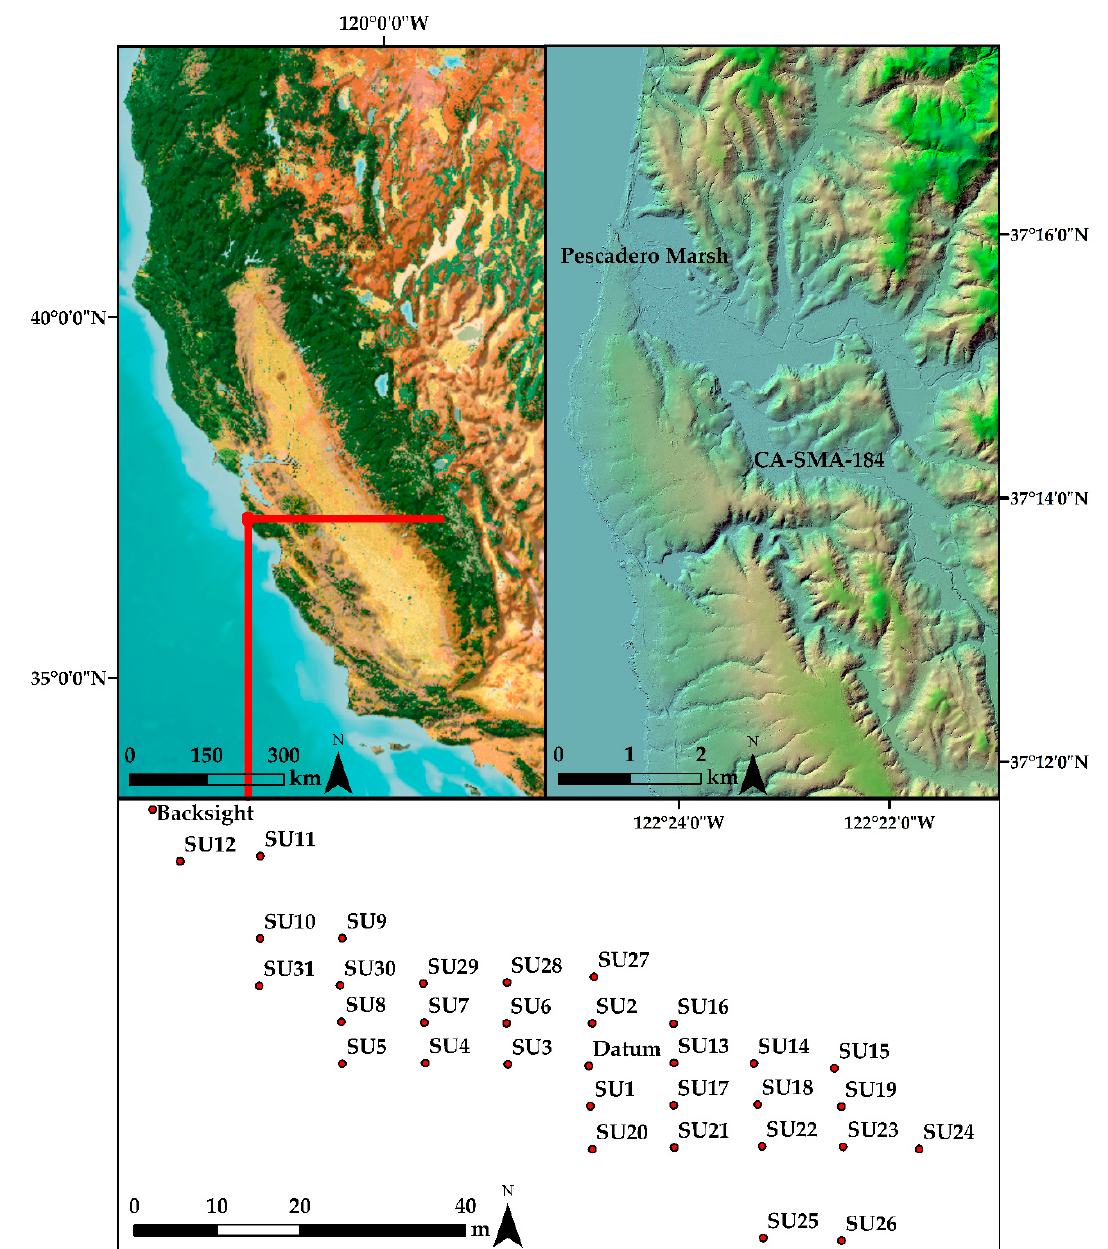
Figure 1. Left : Overview of the California coast with the general location of the study area. Right : Inset map of the project area, including Pescadero Marsh and the location of the CA-SMA-184, otherwise known as the Butano Mound. Bottom : Schematic of the surface survey units (SU) at CA-SMA-184. The exact location of the mound is excluded to protect the site.